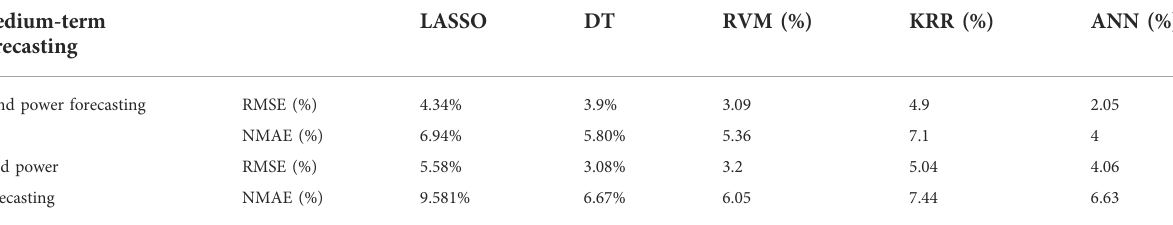
TABLE 6 Performance comparison of medium-term wind power production and load demand prediction using different ML techniques. Medium-term